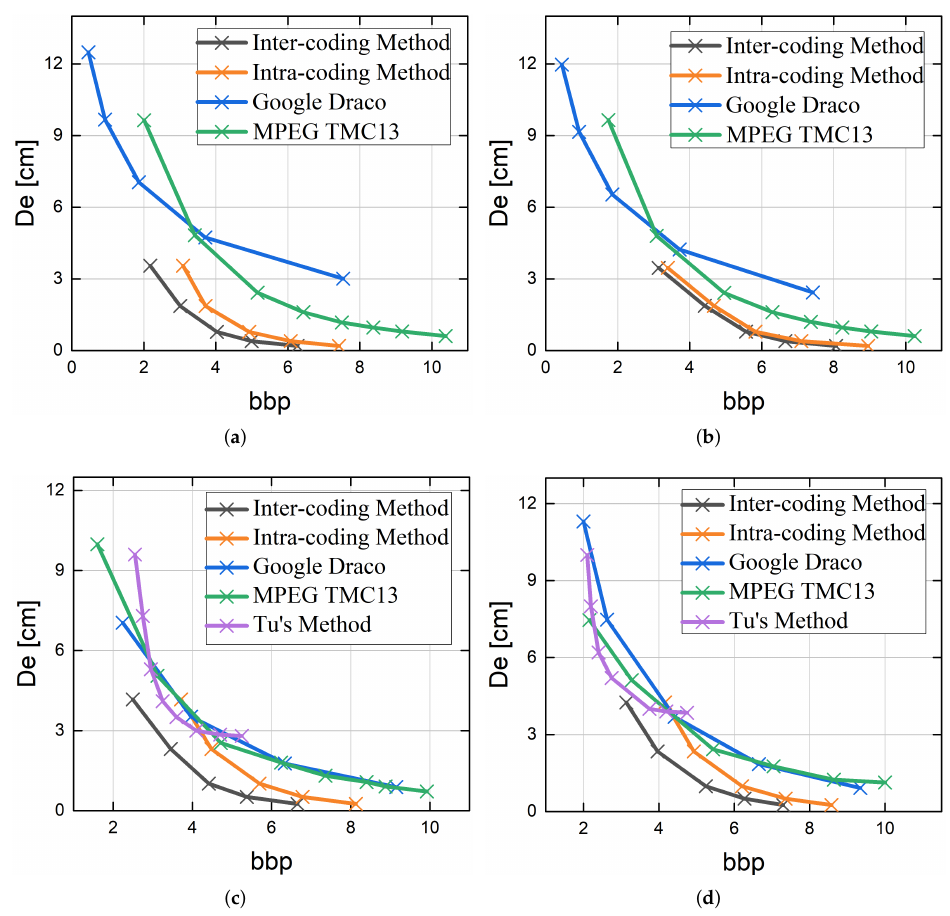
Figure 6. D d - bpp curves of our method in compared to Google Draco [28], MPEG TMC13 [20] and Tu’s method [26]: ( a ) campus , ( b ) city , ( c ) road , and ( d ) residential